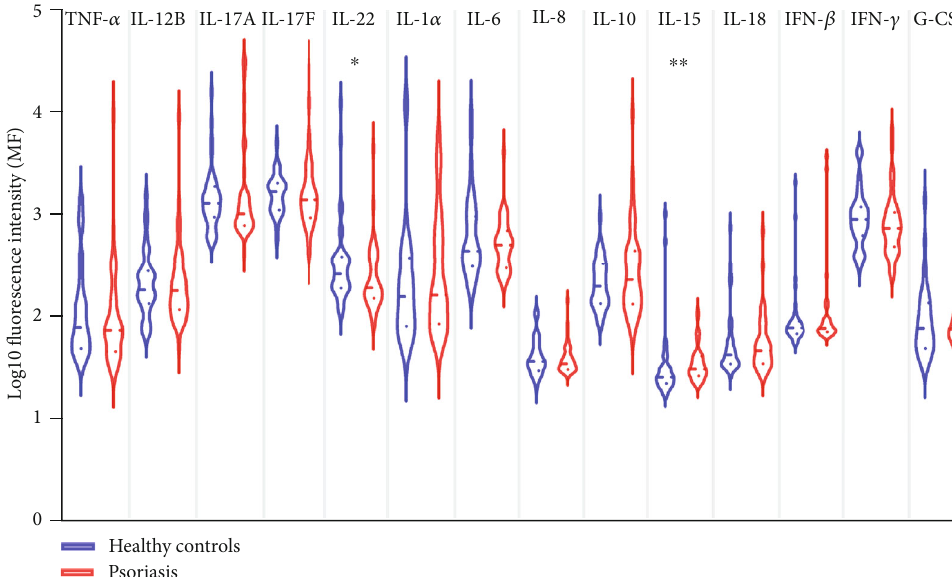
Figure 5: Pro fi le of serum autoantibodies against cytokines (ACAAs) in healthy controls and psoriasis patients. Mean fl uorescence intensity (MFI) of autoantibodies against TNF- α , IL-12B, IL-17A, IL-17F, IL-22, IL-1 α , IL-6, IL-8, IL-10, IL-15, IL-18, IFN- β , IFN- γ , and G-CSF in HC ( n = 40 ) and PSO ( n = 44 ) are measured by multiplex bead-based technology. Dotted line shows median and quartile. ∗ p < 0 : 05 , ∗∗ p < 0 : 01